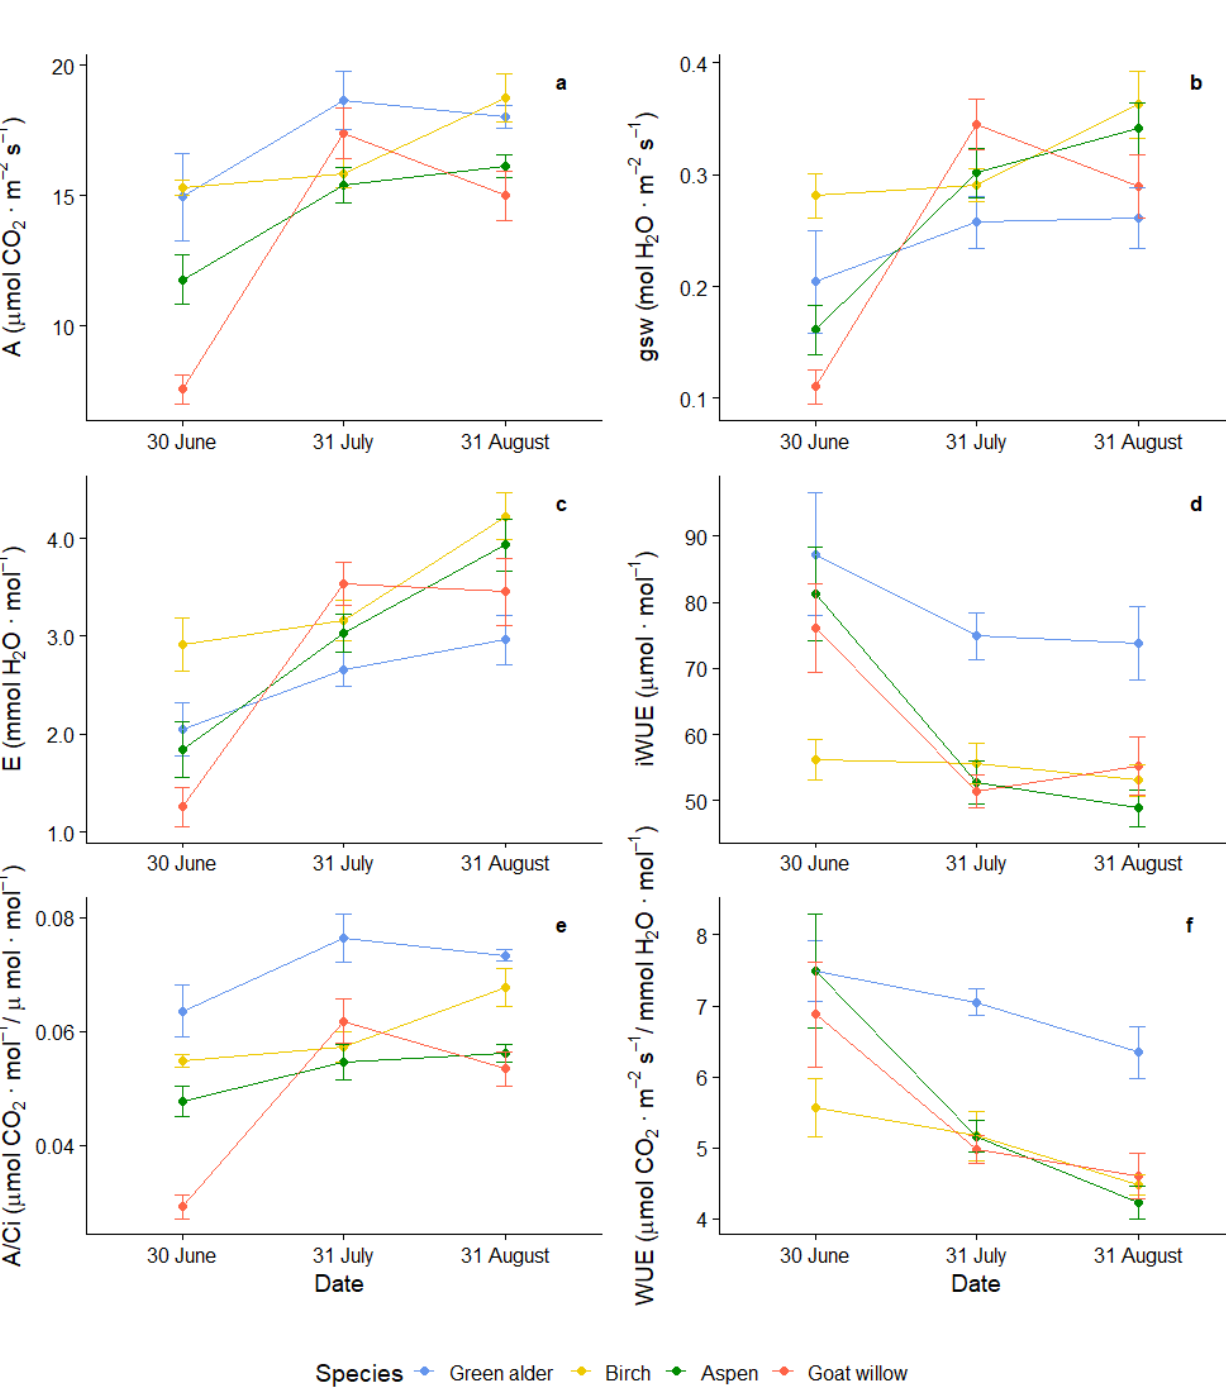
Figure 2. Variability in photosynthetic parameters during the 2019 growing season for deciduous pioneer species on a tailing dump in the C ă limani Mountains. ( a ) Net assimilation rate, ( b ) stomatal conductance, ( c ) transpiration rate, ( d ) intrinsic water use efficiency, ( e ) instantaneous carboxylation efficiency, ( f ) water use efficiency (points are mean values, and whiskers represent standard errors).